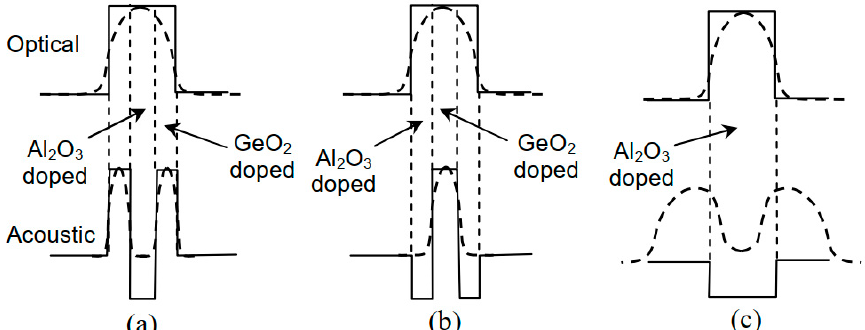
Figure 9. Dopant designs for acoustic tailoring. ( a ) the Al 2 O 3 dopant at the inner core region and the GeO 2 dopant at the outer core region, ( b ) the GeO 2 dopant at the inner core region, the Al 2 O 3 dopant at the outer core region, and ( c ) the Al 2 O 3 dopant at both the inner core and outer core region. [Reprinted/Adapted] with permission from [86] © The Optical Society.